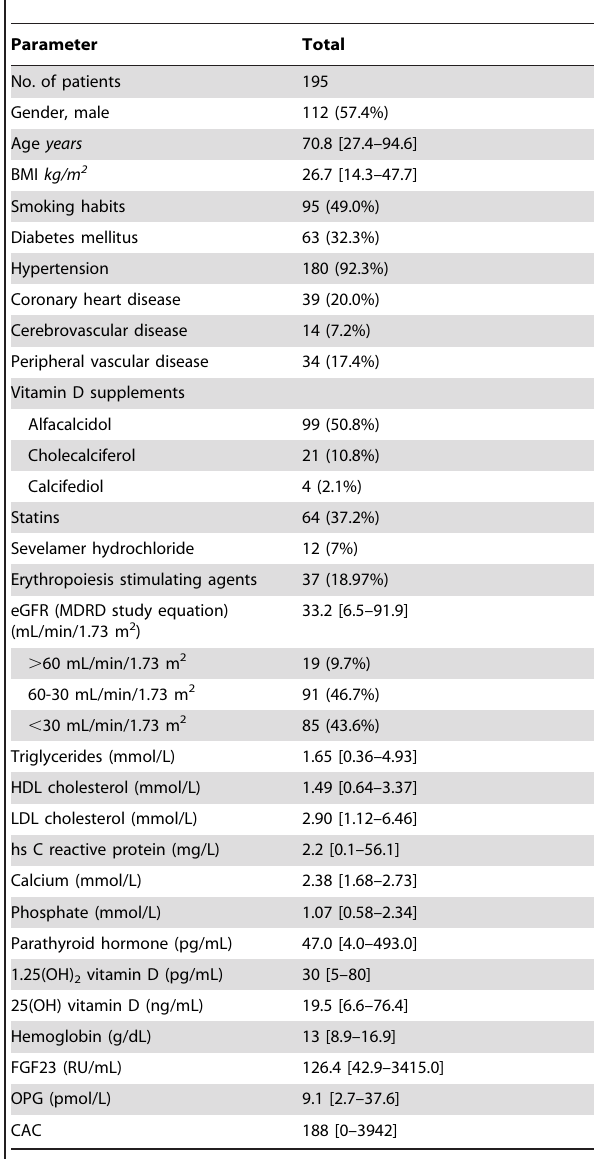
Table 1. Characteristics of the chronic kidney disease